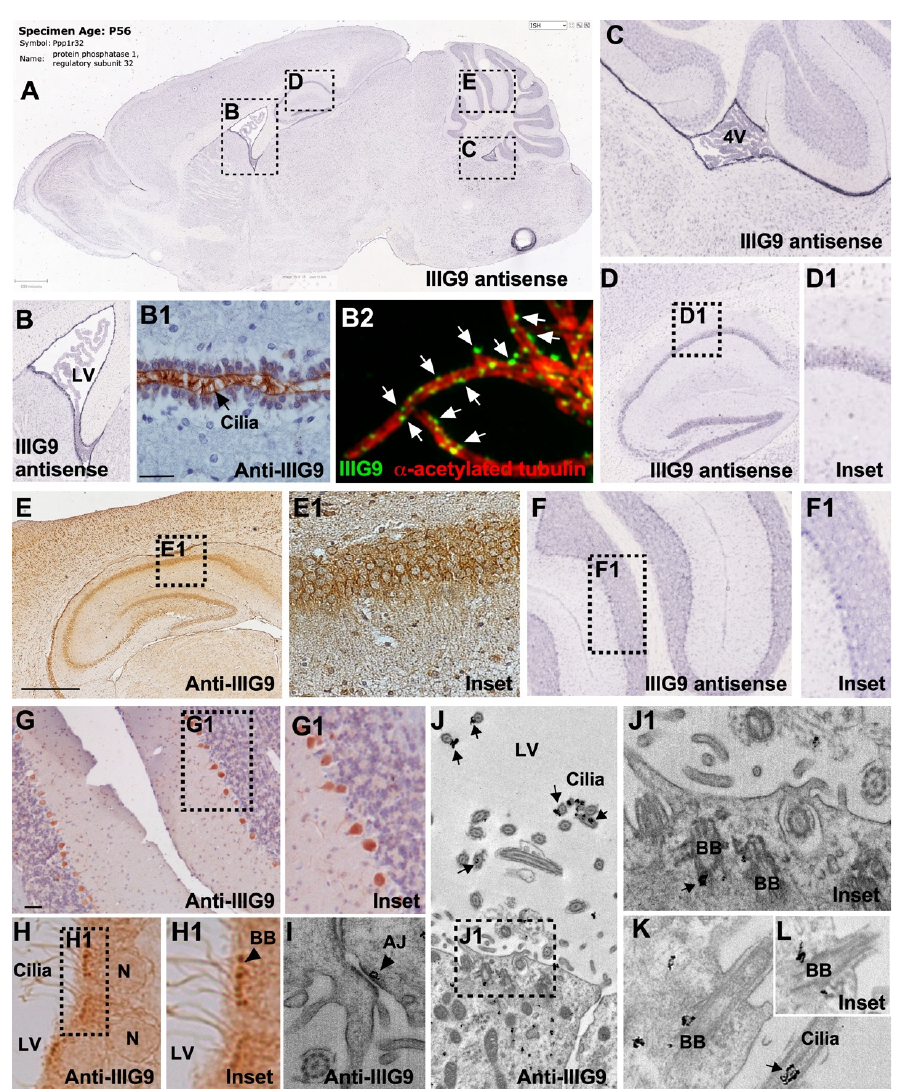
Figure 4. Comparison between IIIG9 mRNA expression and protein localization in the adult brain. ( A ) In situ hybridization analysis in adult mouse brain reported in Allen Brain Atlas for the PPP1R32 gene. ( B , C , D – D1 , F – F1 ) High-magnification image for antisense riboprobe in ependymal cell from lateral and fourth ventricles, neurons from hippocampus, and Purkinje cells from the cerebellum. ( B1 , E – E1 , G – G1 ) Immunohistochemical characterization of IIIG9 showing a positive reaction in the cilia and apical membrane of ependymal cells from the dorsal third ventricle and in the soma of hippocampal and Purkinje neurons. ( B2 ). Super-resolution SIM showing IIIG9 dotted pattern (green, arrows) and alpha acetylated tubulin cilia (red) from isolated rat ependymal cells. Sagittal and frontal sections of mouse brain were immunostained with anti-IIIG9 (1:500) and a secondary antibody conjugated with peroxidase. ( H – L ) Immunohistochemical analysis using anti-IIIG9 antibody and anti- IgG labeled with 10 nm gold particles. ( H – H1 ) In semi-thin sections, IIIG9 is detected in basal bodies of ependymal cilia (arrow). ( I – L ) In ultra-thin sections, IIIG9 was detected in adherens junctions (arrow), between the ring of nine outer microtubule duplets and the ciliary membrane (arrows), and in the basal bodies (arrow). Magnification in ( H ): × 100. Scale bars: A : 839 µ m; ( B1 ): 50 µ m; ( E ): 1 mm; ( G ): 60 µ m; ( J ): 1 µ m. ( B – C , D – D1 , F – F1 , J1 , K – L ) correspond to digital magnification showing IIIG9 detected in the basal bodies, and between the ring of nine outer microtubule duplets and the membrane of a motile cilia (arrow) (complementary images and results from